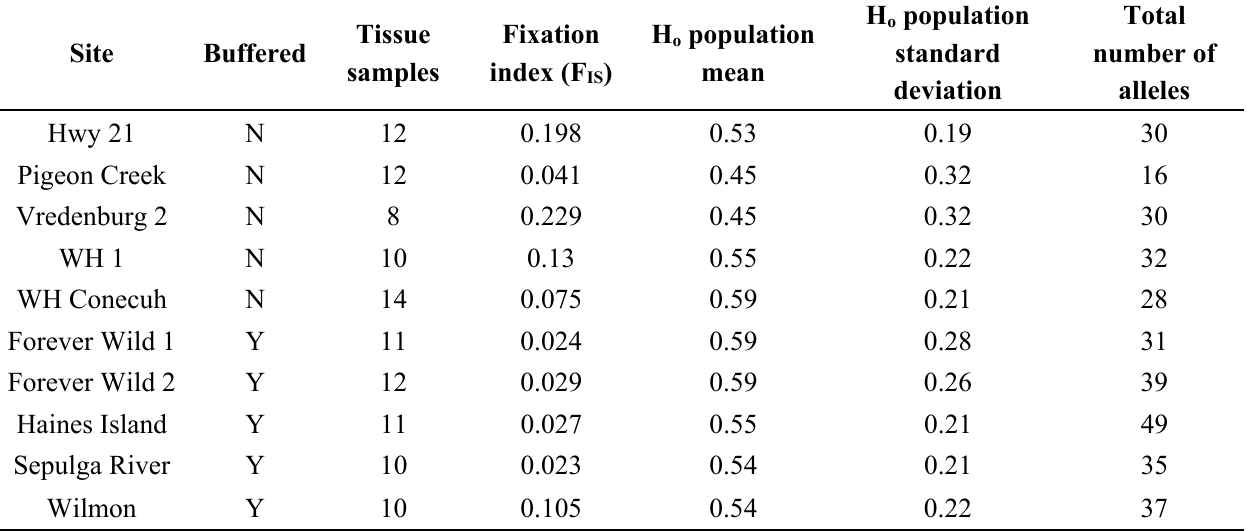
Table 2 . Genetic data from the sites used in this study. H o , observed